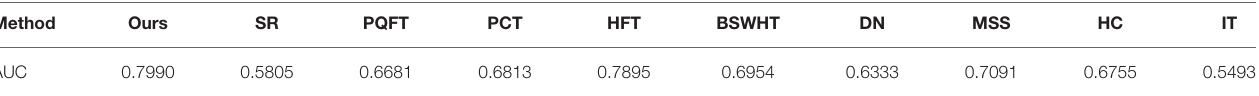
TABLE 2 | The ROC-AUC scores of all nine saliency methods.